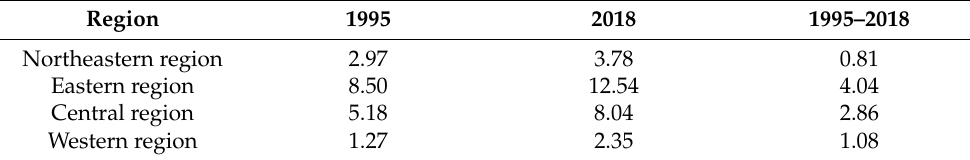
Table 2. Average value of the land development intensity in the RBCs in the different regions (%).